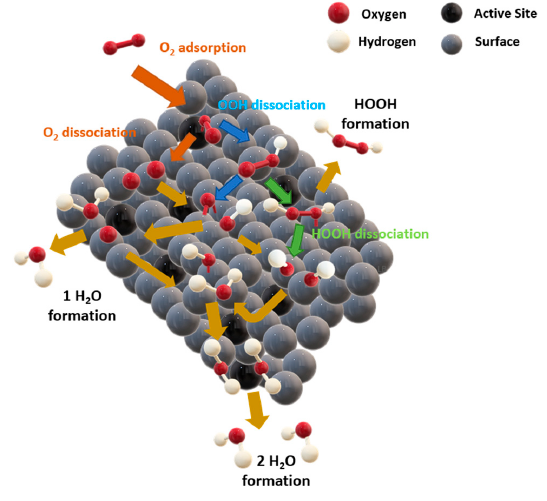
Figure 22. Schematic representation of dissociative ORR mechanism.